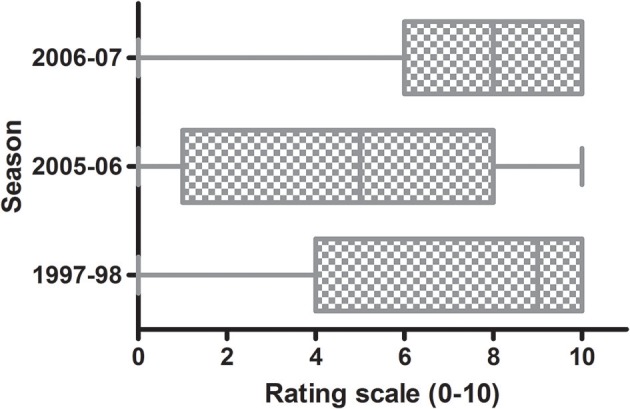
Box plots of fruit-rot incidence (0–10) caused by Colletotrichum acutatum in 308 olive cultivars in the World Olive Germplasm Bank of Córdoba in three epidemic seasons. Each box represents the distribution of fruit-rot incidence data according to rating scale 0–10 (Moral and Trapero, 2009). The line within the box is the median. The top and bottom lines of the box represent 25 and 75th percentile of the data. Lines extending horizontally beyond the box represent the 5 and 95th percentiles.